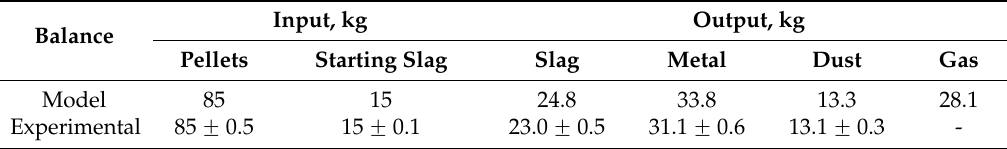
Table 6. Material balance of the melting process.